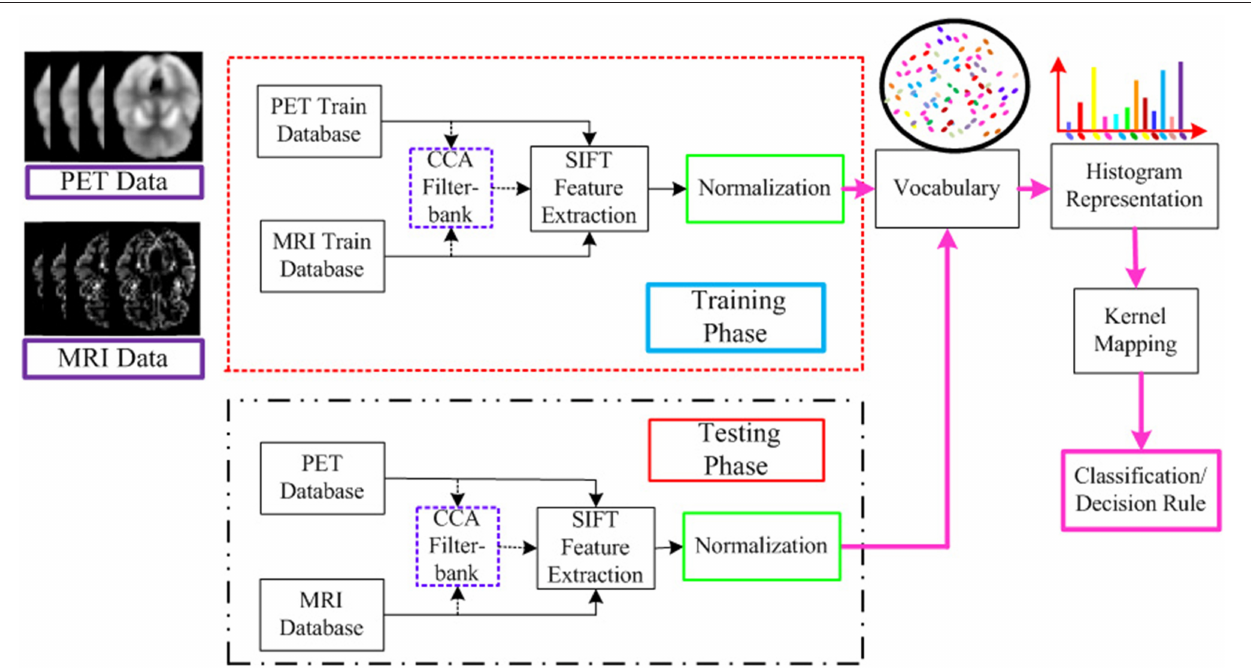
FIGURE 1 | Flowchart for the AD/MCI diagnosis system. Feature extraction is based on both MRI and PET data. For the input MRI and PET data, CCA is first performed to extract the shared information between MRI and PET. And then the visual feature is extracted based on both the input MRI and PET data, and the fused data after CCA filterbank. A histogram representation is established based on the extracted feature by the standard BoF pipeline. The kernel mapping and normalization are applied to facilitate the classification. The final AD diagnosis results are based on the decision rule in the SVM classifier.